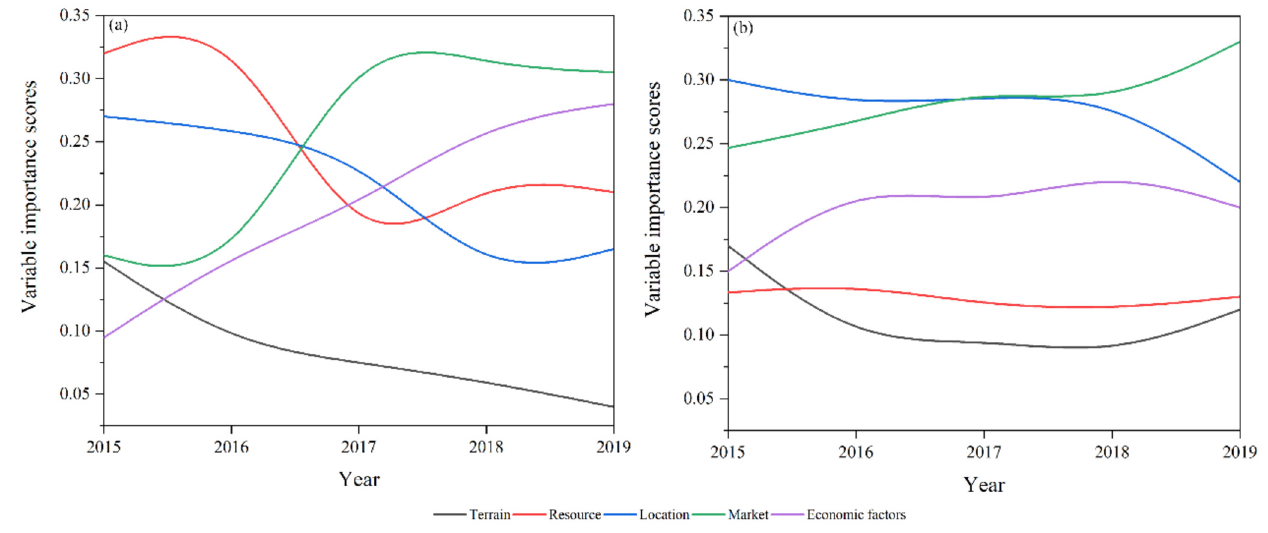
Figure 4. Factors accounting for long-term SAV development north ( a ) and south ( b ) of Huai